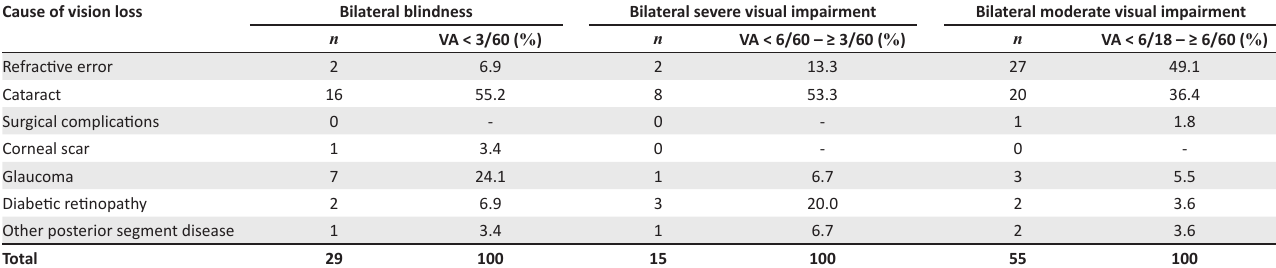
TABLE 3: Causes of visual loss (with available correction) in the study sample. Cause of vision loss